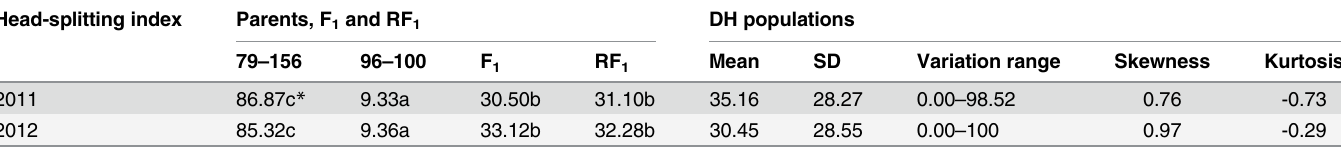
Table 1. Statistical summary of head splitting resistance in parents, F 1 , RF 1 , and doubled haploid (DH) populations. Head-splitting index